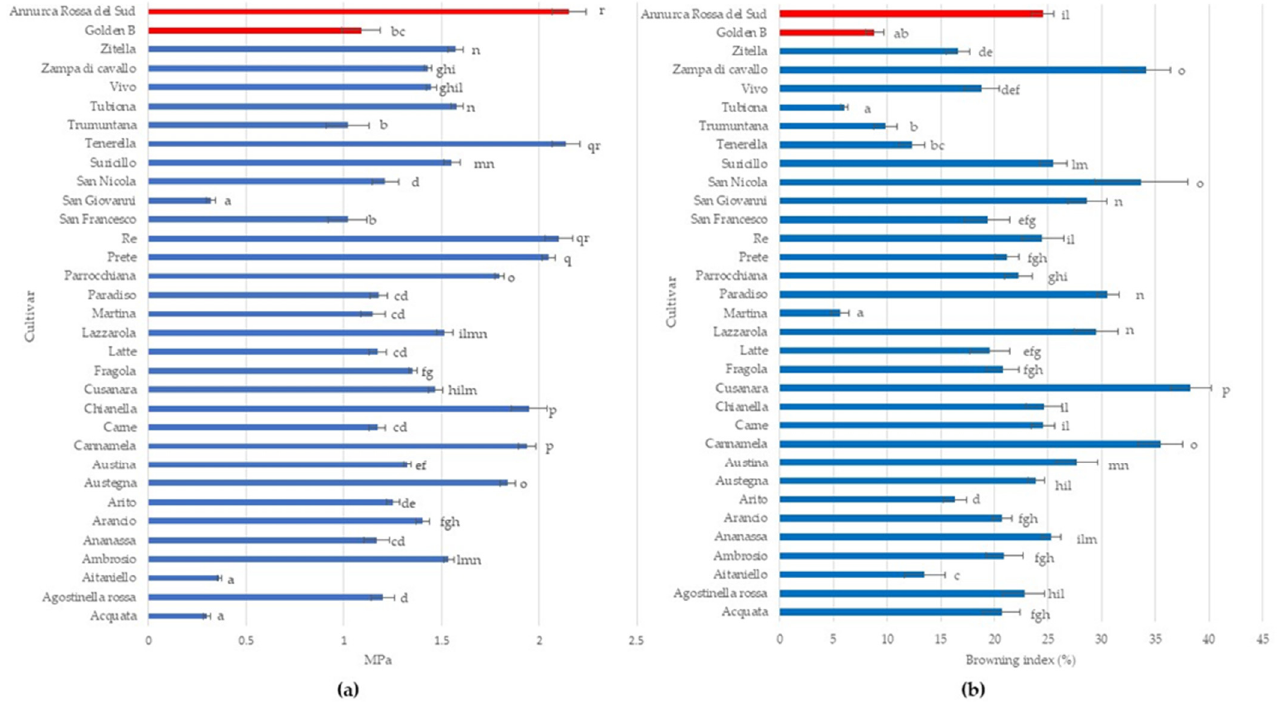
Figure 2. Young’s module ( a ) and enzymatic browning ( b ) in the 31 autochthonous apple cultivars